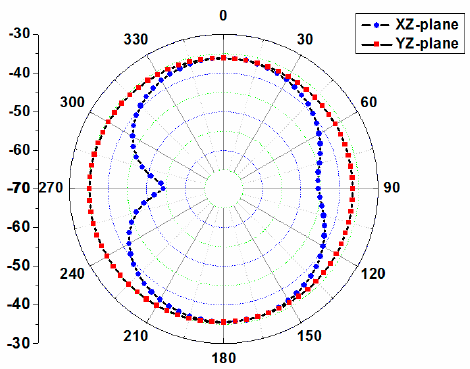
Figure 8. Simulated 2D patterns for the proposed implantable antenna at 402 MHz.